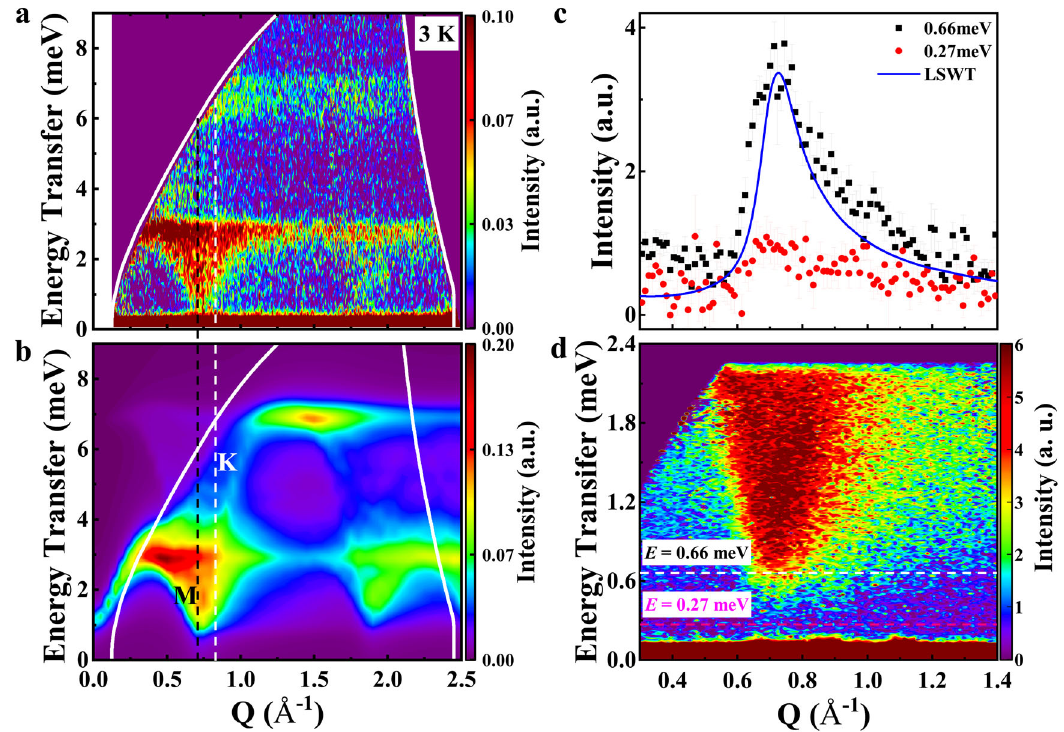
Fig. 5 Powder INS of Na 2 Co 2 TeO 6 . a Powder INS using 11.4 meV incident neutron for NCTO at 3 K on spectrometer HRC. The high-temperature data (95 K) was subtracted as background and the thermal effect was simulated by the Bose factor. b The calculated powder-averaged scattering including the magnetic form factor with K = Γ = 0.125 meV, J = − 2.325 meV, and J 3 = 2.5 meV. The black and white dashed lines label M and K points at the fi rst Brillouin zone with Q = 0.72 and 0.83 Å − 1 , respectively. c Constant- E cuts over the energy ranges centered at the locations labeled dashed lines in Fig. 5d. The solid blue line is constant- E cuts over the energy ranges centered at 0.66 meV from our LSWT. The absence of structured scattering below 0.4 meV con fi rms the gap in the magnetic excitation spectrum. d Powder inelastic neutron scattering using 5 Å (~3.27 meV) incident neutrons for NCTO at T = 3 K on spectrometer NEAT II, HZB,